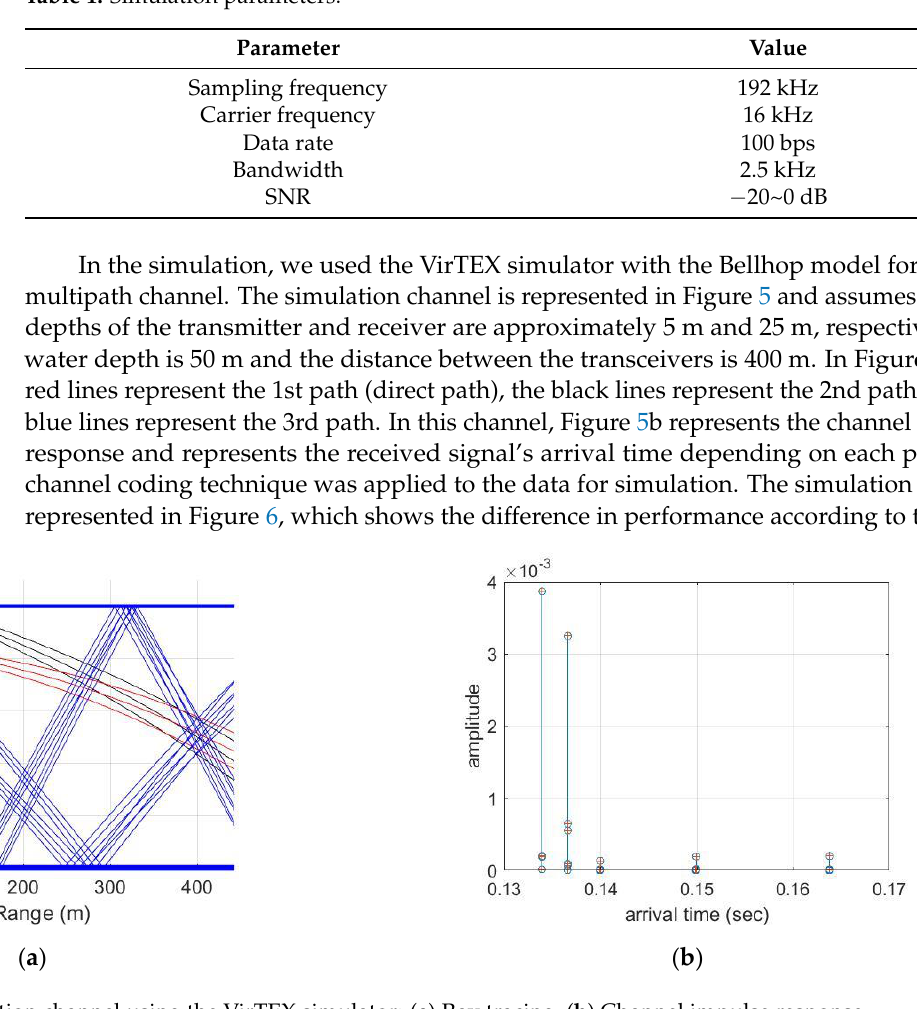
Table 1. Simulation parameters.